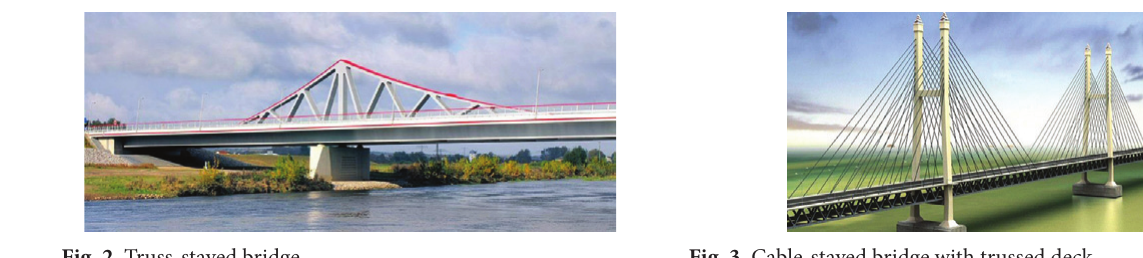
Fig. 1. Scheme of Warren truss with rigid bottom flange